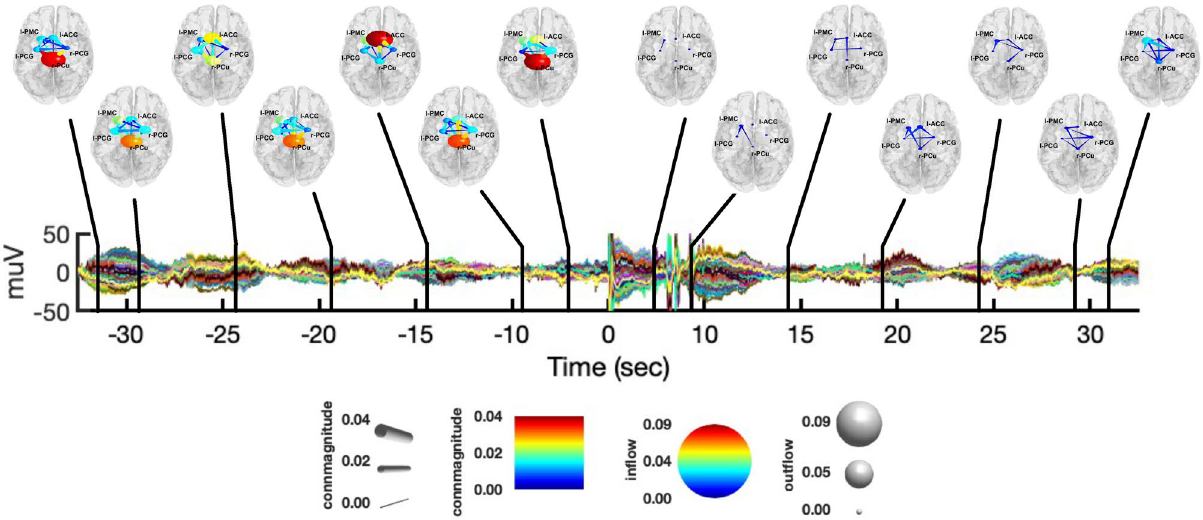
Figure 7. Graphical representation of causal interactions between the network nodes (i.e., l-PCG, l-PMC, r-PCu, l-ACC and r-PCG) integrated in the α and σ bands, during both the resting-state from − 35 to − 5 s and CPT from + 5 to + 35 s, with respect to the CPT start. Nodes are reported in a standard template, with their corresponding label. Node size represent information outflow, whereas node color represents information inflow. The edges represent connections between nodes, whose color and size encode connectivity magnitude. The directionality of connections is given by the direction were the edges